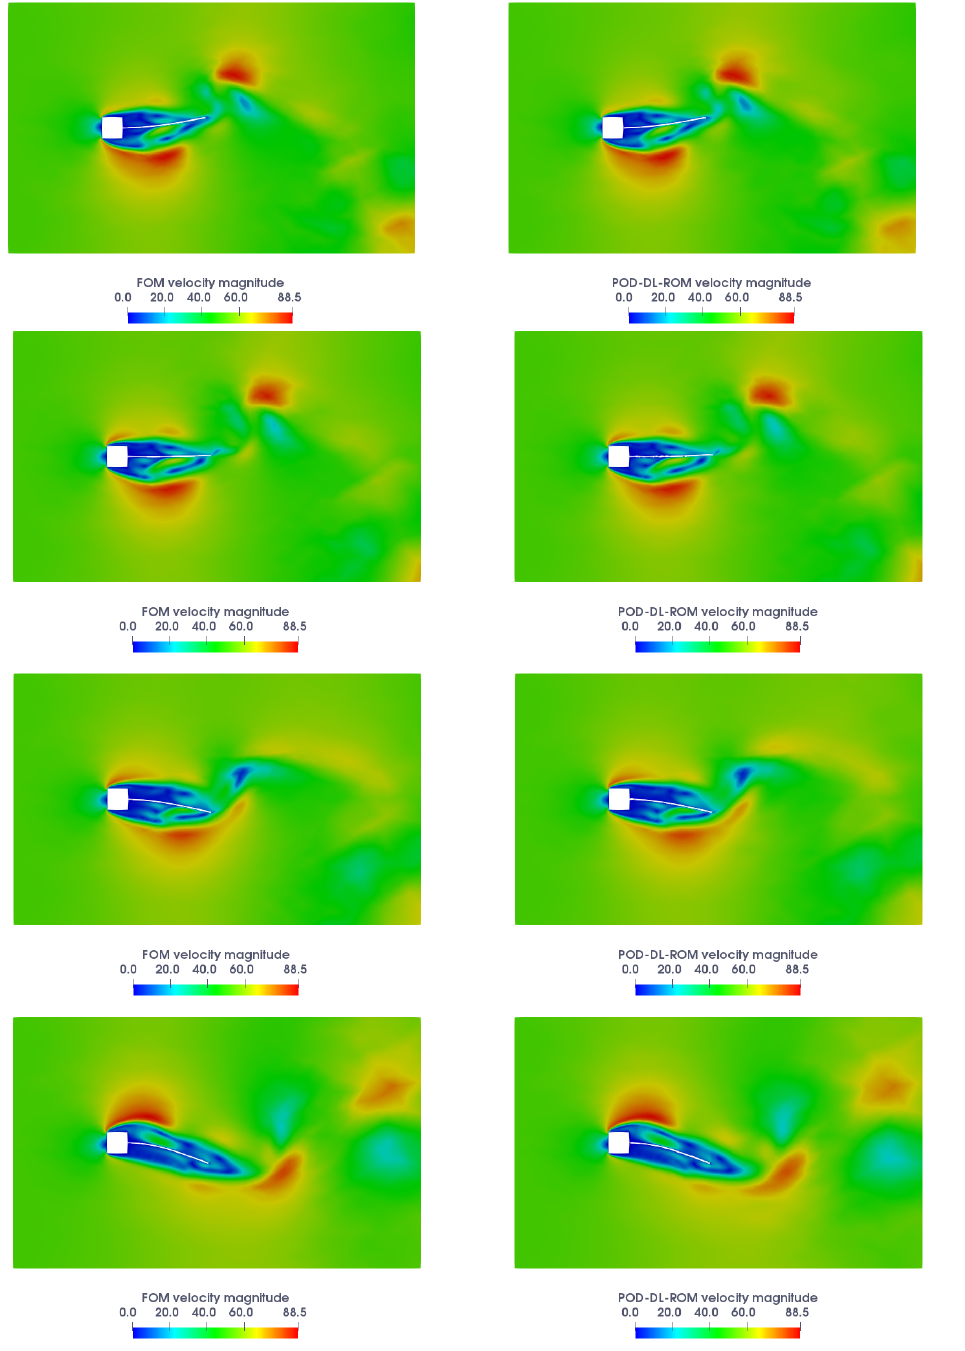
Figure 8. Test case 2: FOM ( left ) and POD-DL-ROM ( right ) fluid velocity magnitudes for the = [ 2.3 × 10 6 g/(cm · s 2 ),0.325 ] (rows 1–2) and µ testing-parameter instances µ test 10 6 g/(cm · s 2 ),0.375 ] (rows 3–4), at t = 2.3084 s ( top ) and t = 2.64 s ( bottom